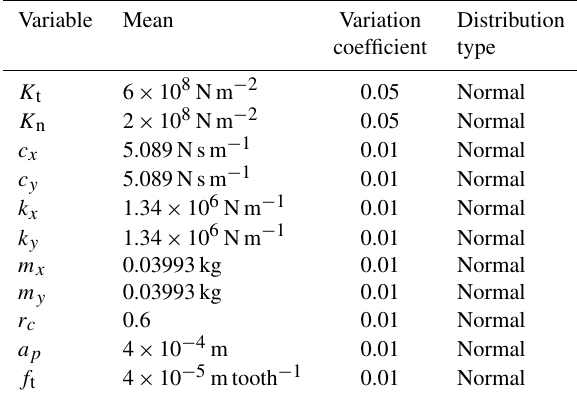
Table 1. Probabilistic features of the random variables.